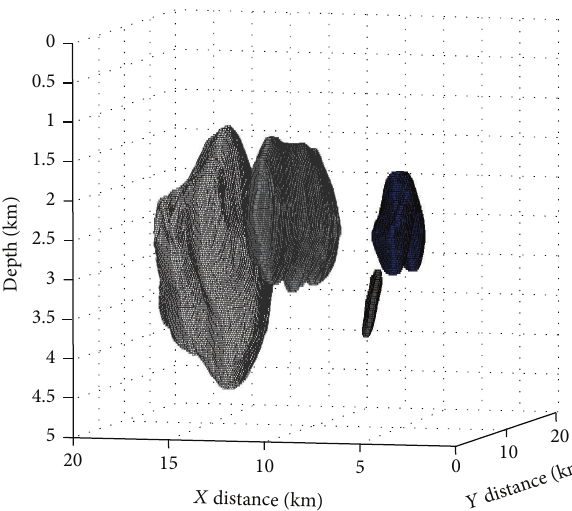
Figure 2: Salt bodies interpreted from a 3D PSDM velocity model. Each body is composed of many discrete points with a regular volume grid